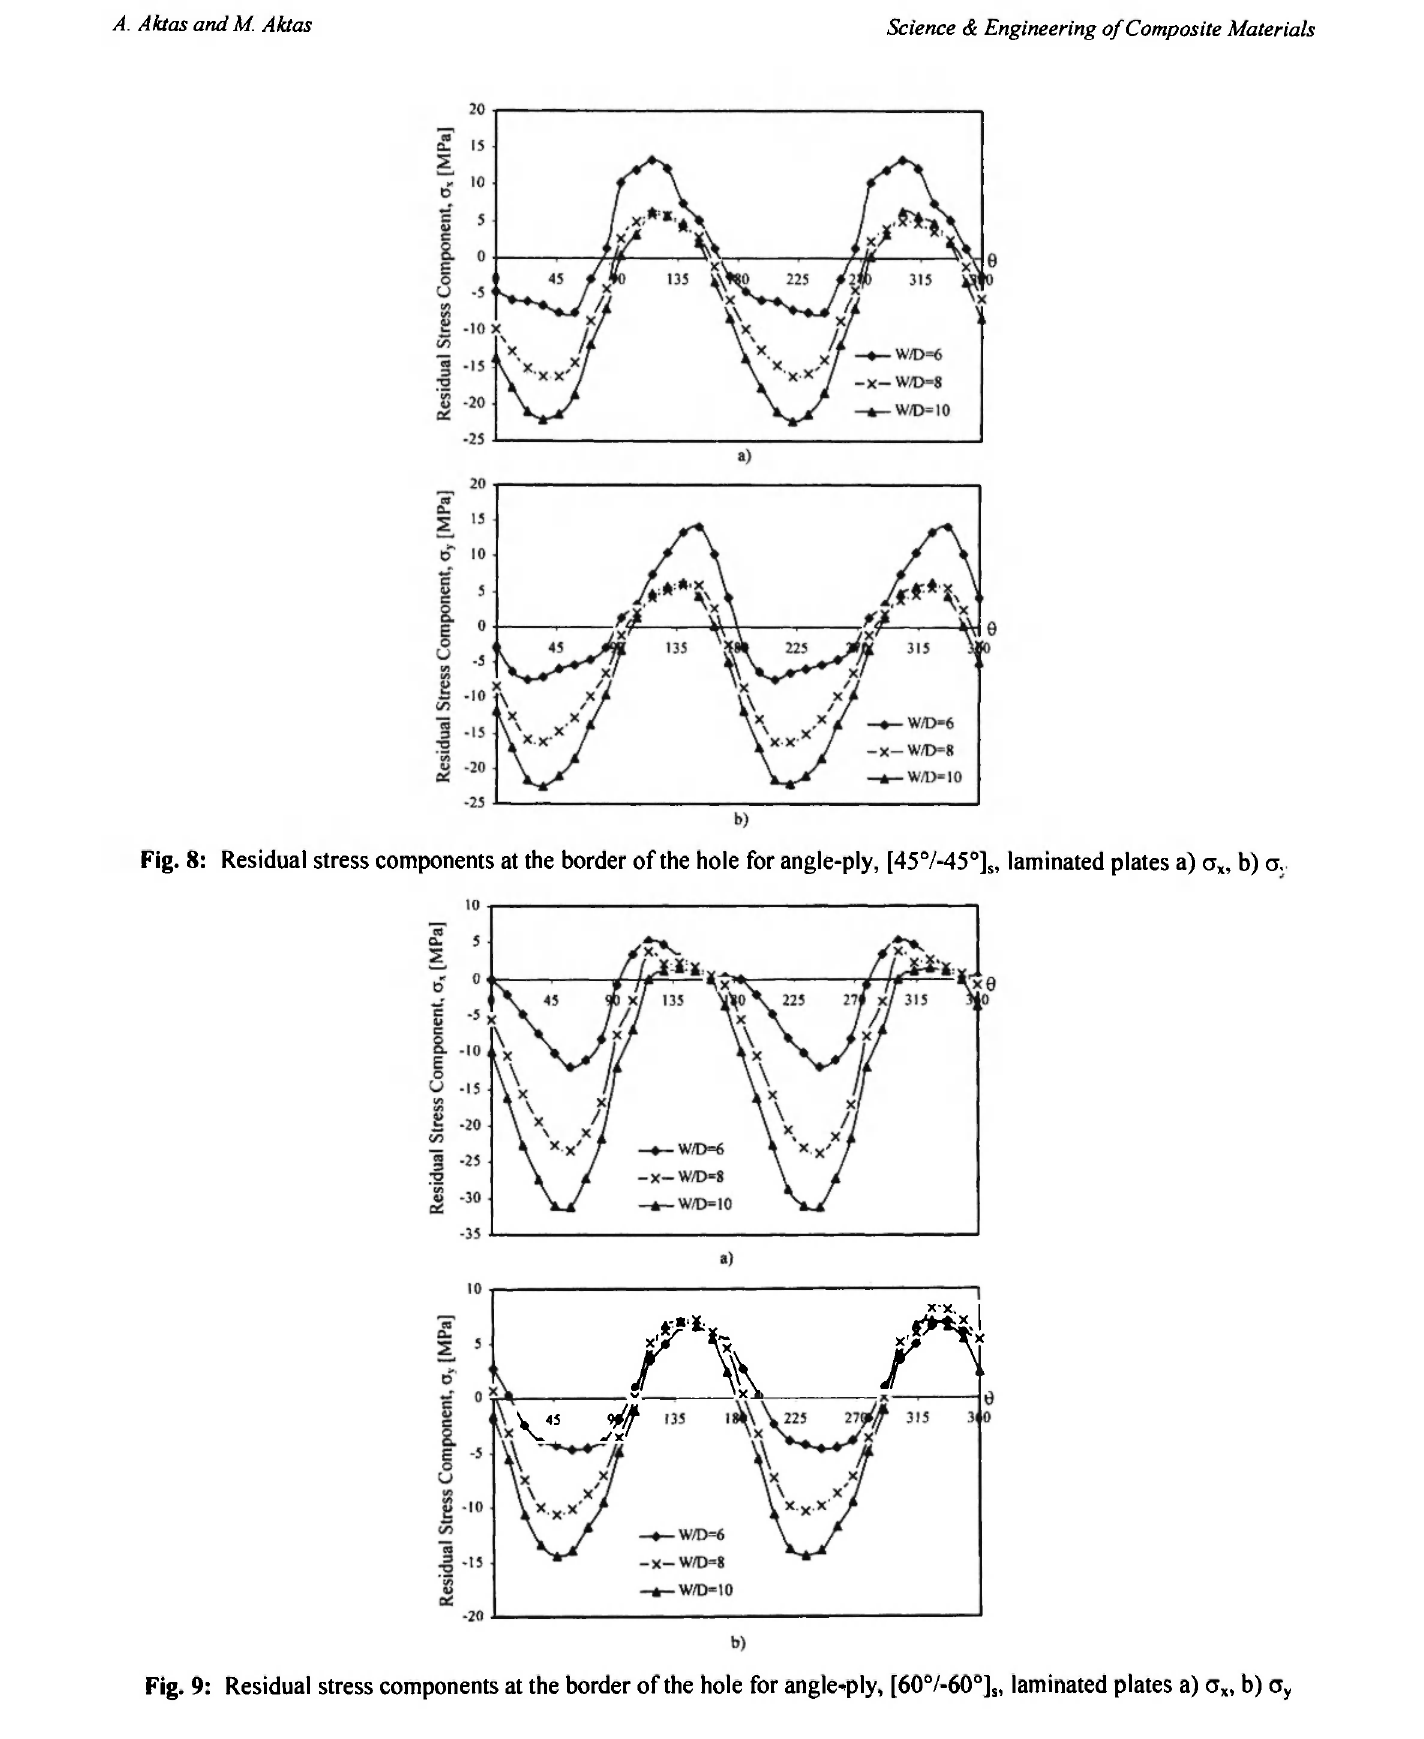
Fig. 9: Residual stress components at the border of the hole for angle-ply, [60°/-60°] s , laminated plates a) σ χ , b) a